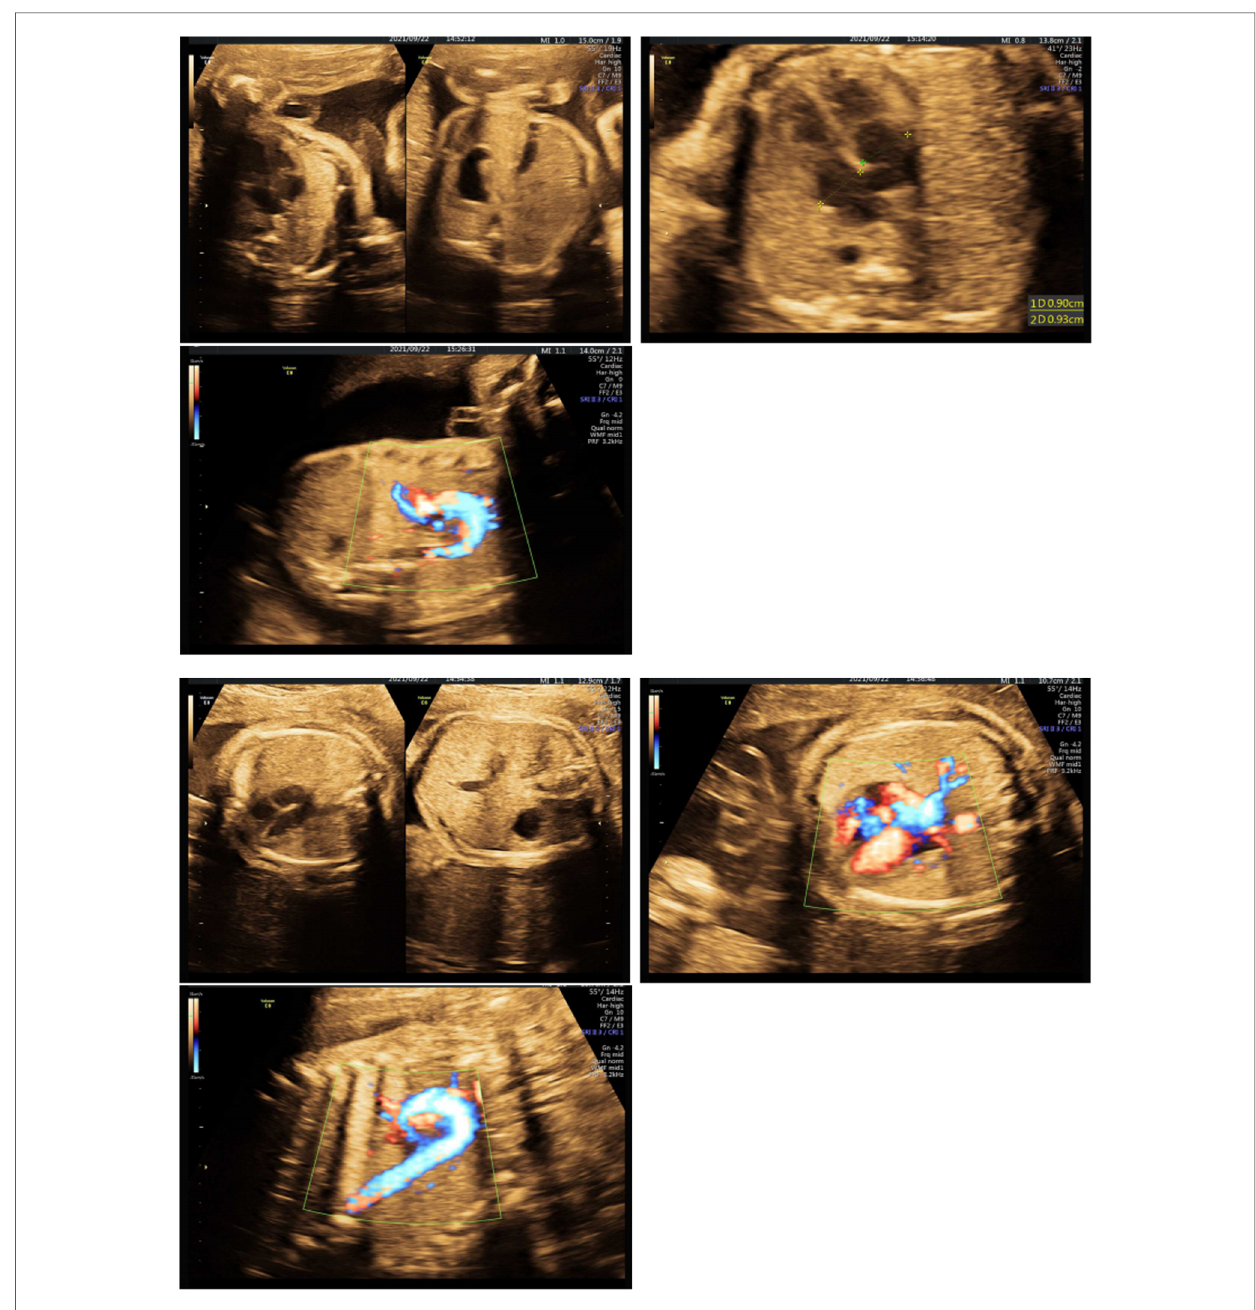
FIGURE 3 Doppler echocardiography of two